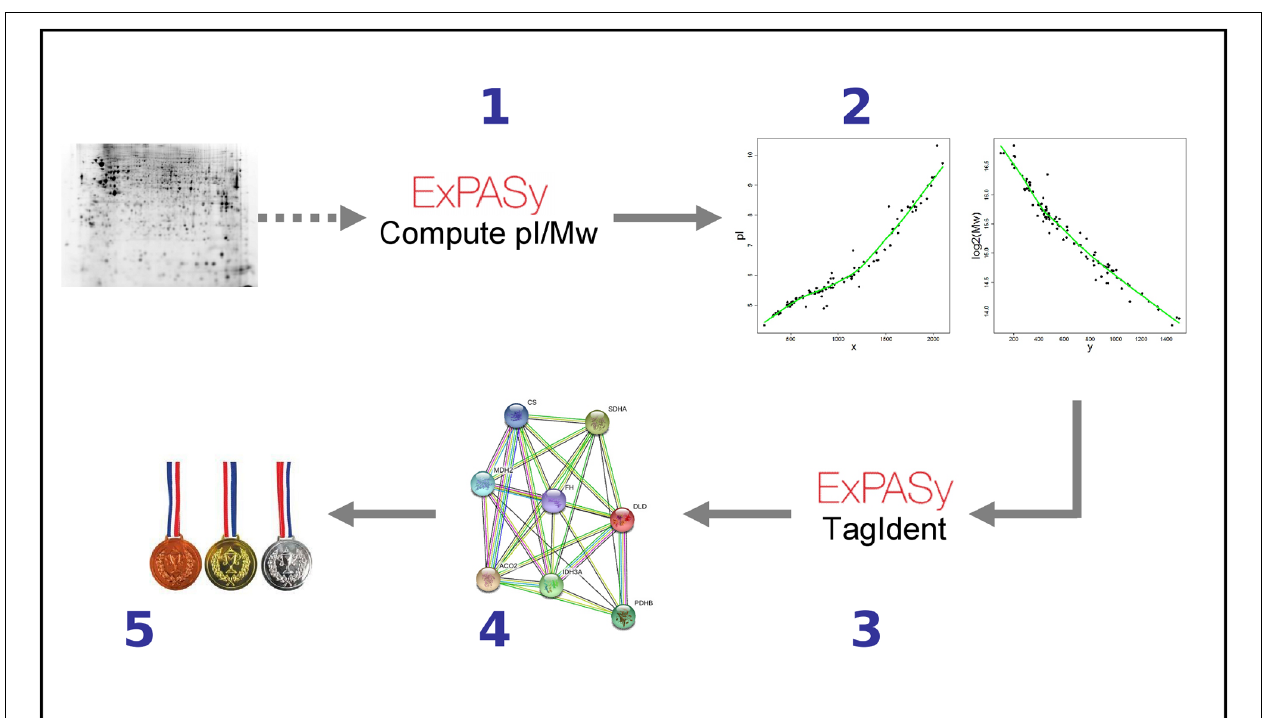
FIGURE 2 | How to identify candidate proteins based on p I and Mw. For details see